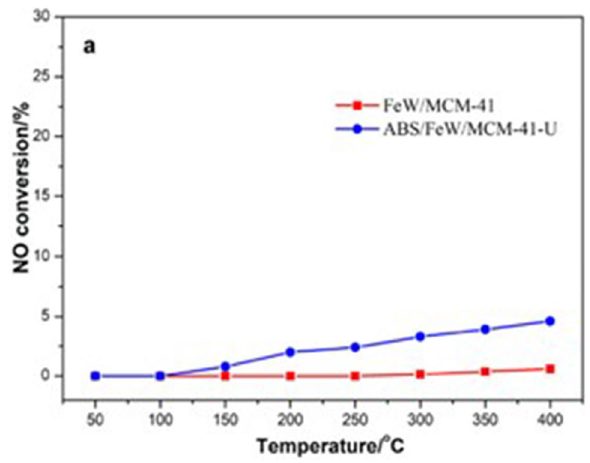
Figure 8. NO oxidation performance test of FeW/MCM-41 catalyst before and after loading ABS 30